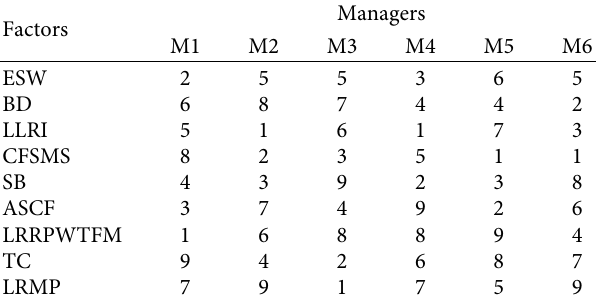
Table 2: Te ranking of factors.